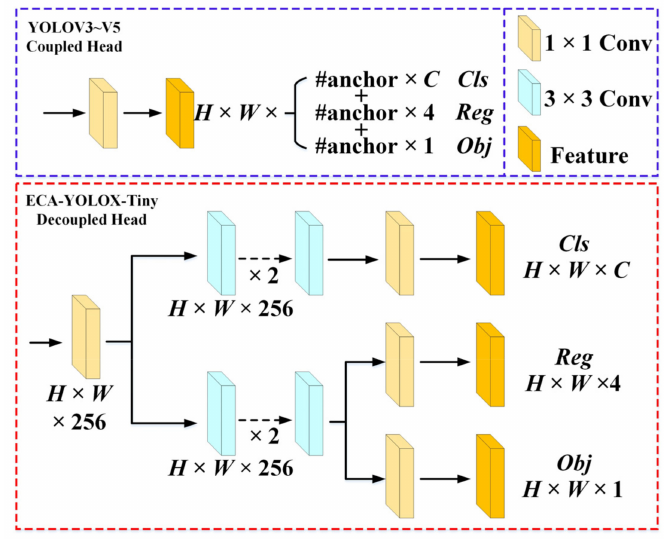
Figure A5. The comparison between coupled head and decoupled